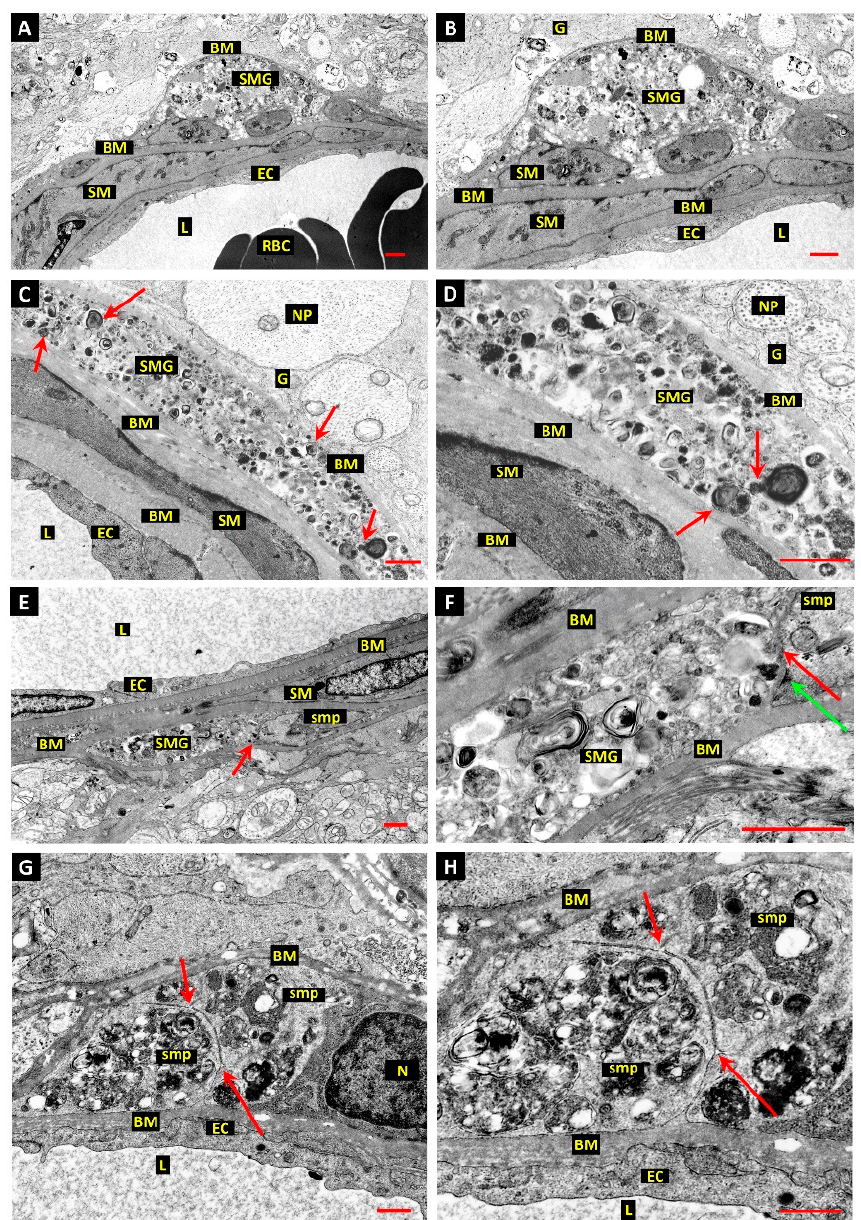
mural cell processes filled with autophagosomes (panel G—thick arrows). Panel G: Red blood cell (RBC); basement membrane vacuolisation (Vac). The plasma membranes are intact and double membranes can be defined around several of the autophagic bodies (stars in panels H and I). Fusion between autophagic bodies, or secondary lysosomes, and autophagosomes is evident (red arrows in panel H). One process is divided by tightly apposed plasma membranes with no associated basal lamina, suggesting cytoplasmic cleavage (green arrow in panel H). Two apparently normal pericyte processes (np) are also present (panels G and I). Bar 1.0 µ m.